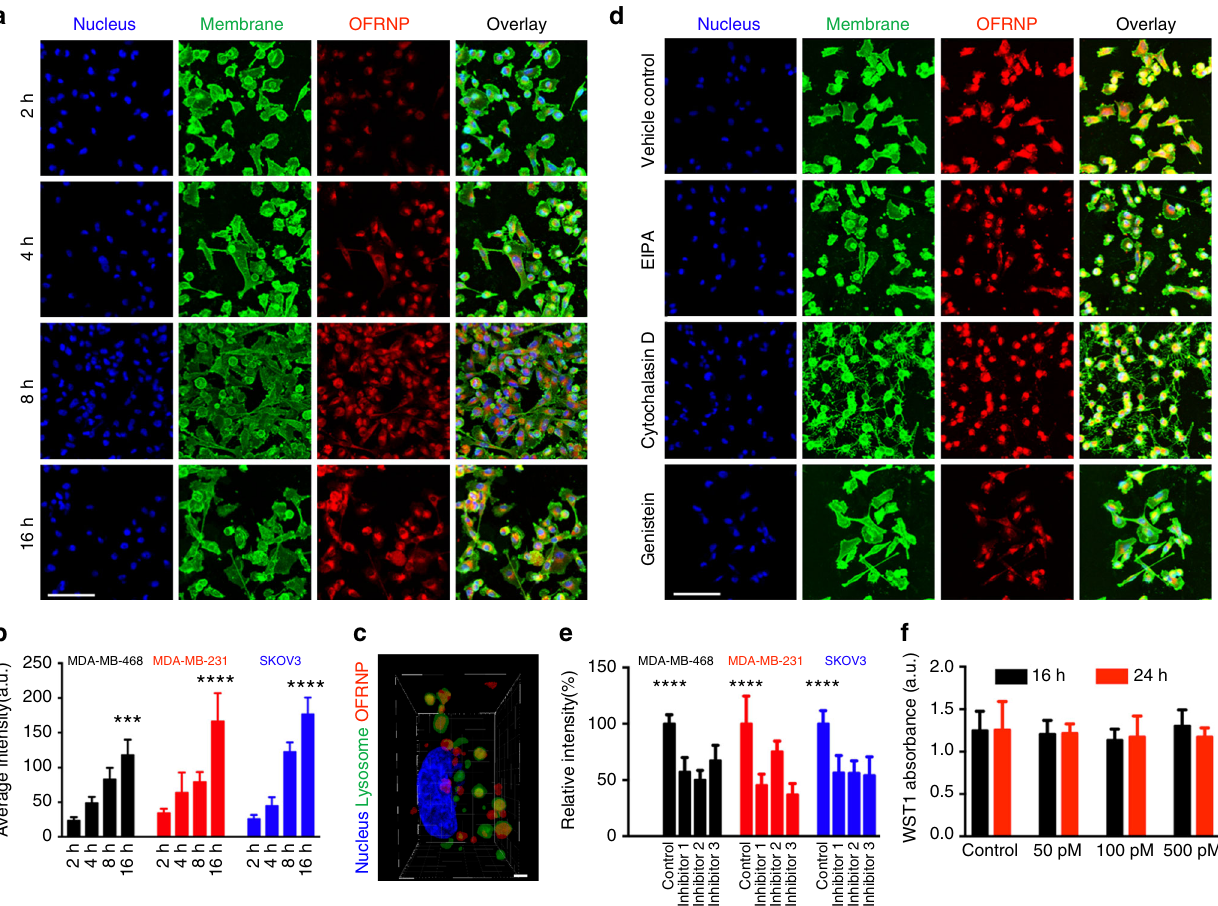
Fig. 5 In vitro uptake and toxicity of OFRNPs. a Fluorescence microscope images of MDA-MB-231 cells incubated with 100 pM of OFRNPs at different incubation times of 2, 4, 8, and 16 h. Longer incubation time increase uptake of the OFRNPs shown as red. Cell nucleus and membrane were stained with Hoechst ® 33342 and wheat germ agglutinin, AF488 conjugate respectively. b Quanti fi cation of intracellular fl uorescence of MDA-MB-468 (black), MDA- MB-231 (red), and SKOV-3 (blue) cells at different durations of incubation with 100 pM of OFRNPs. Scale bars are 100 µ m. c After 16 h of incubation time, OFRNPs were localized into the cytoplasm in the lysosomal compartments labeled in green. Scale bar is 1 µ m. d Fluorescence microscope images of MDA- MB-231 cells incubated with 100 pM of OFRNPs in the presence of different endocytosis inhibitors, 75 μ M EIPA (inhibitor 1), 10 μ g/mL Cytochalasin D (inhibitor 2), 2 μ M Genistein (inhibitor 3). e Quanti fi cation of relative fl uorescence intensity of MDA-MB-468 (black), MDA-MB-231 (red), and SKOV-3 (blue) with respect to vehicle control demonstrates diminished endocytosis. f WST1 cell viability assay of MDA-MB-231 cells incubated with 500, 100, and 50 pM of OFRNPs exhibits no cell toxicity of the NPs. All data in ( b , e ) represent mean ± standard deviation ( n = 10), **** P < 0.0001, *** P < 0.001 (one- sided Student ’ s t test). All data in ( f ) represent mean ± standard deviation ( n =